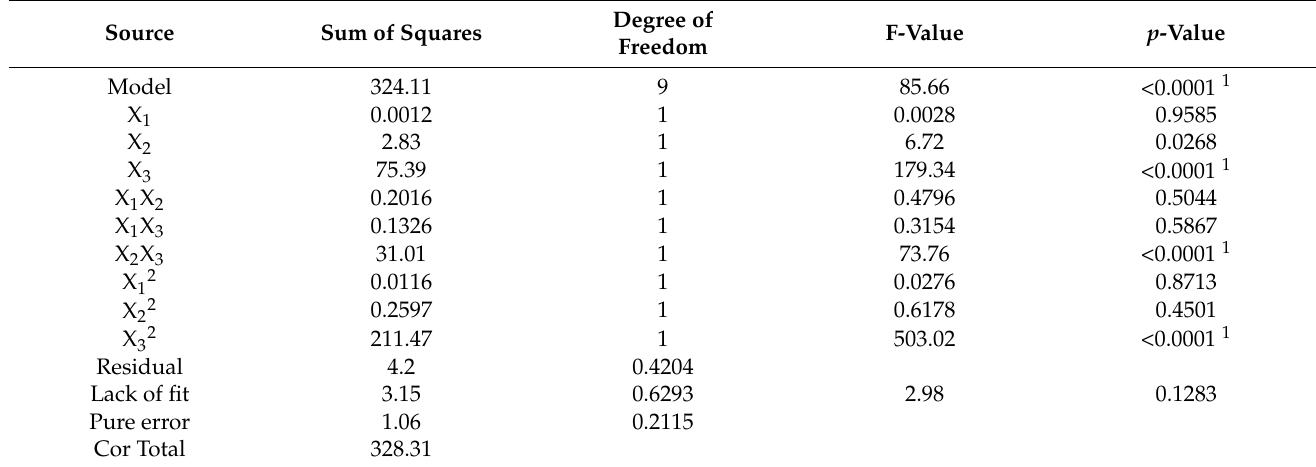
Table 9. Variance analysis of regression